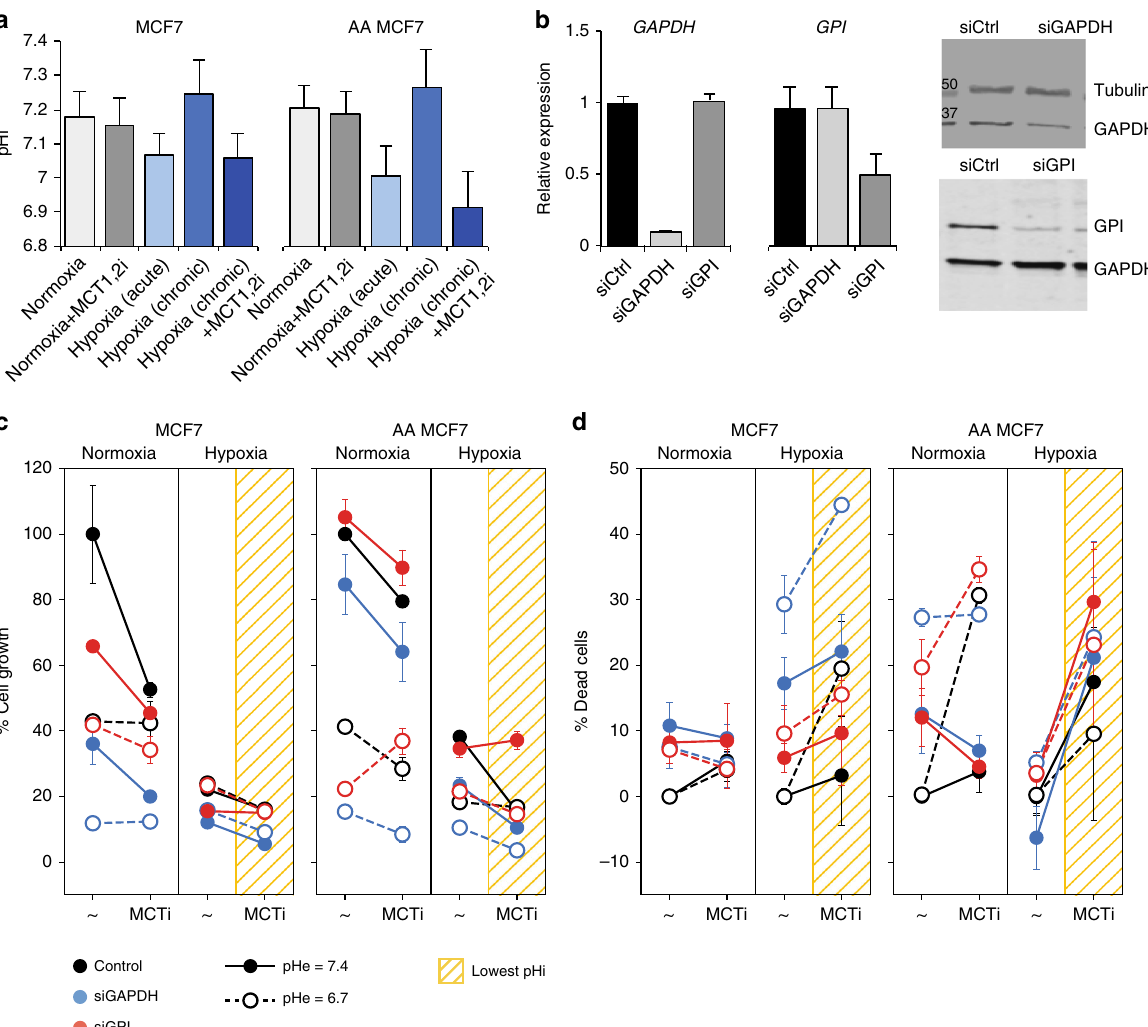
Fig. 3 Experimental proof of concept. a pHi measurements of naïve and acid-adapted (AA) MCF7 breast cancer cells, under different oxygen availability, and following inhibition of MCT1/2 . For pHi measurments at least 30 cells were analyzed. b Ef fi ciency of knockdown of GAPDH and GPI mRNA and protein following transfection of MCF7 cells with the respective siRNAs (72 h). PCR was done in three separate biological replicate with three repeats. c Proliferation assays of cells (Methods) transfected with siRNA targeting GAPDH and GPI , across four conditions: normoxia, hypoxia, each at physiological pHe (7.4), or acidic pHe (6.7). Drop in proliferation following inhibition of MCT1/2 is shown as connected lines. Lowest values are obtained when pHi is low (yellow grids). The ampli fi ed effect of gene inhibition is seen relative to control (color vs. black). Viability assays is done in three replicates and three reads for each time point. d Viability assays (Methods) demonstrate that when pHi is suf fi ciently low the predicted strategy is particularly effective against AA cancer cells. The inhibition of GAPDH and GPI achieve ef fi cient killing of cells at low pHi (yellow grids). Note the large slopes obtained for AA cells. The strategy is selective (Supplementary Figure 14), however, fails when suf fi ciently low pHi is unattainable, as in the case of triple negative breast cancer cells (Supplementary Figure 15). Bars depict the error of the mean over replicas. The experiments were repeated three times with three replicas for